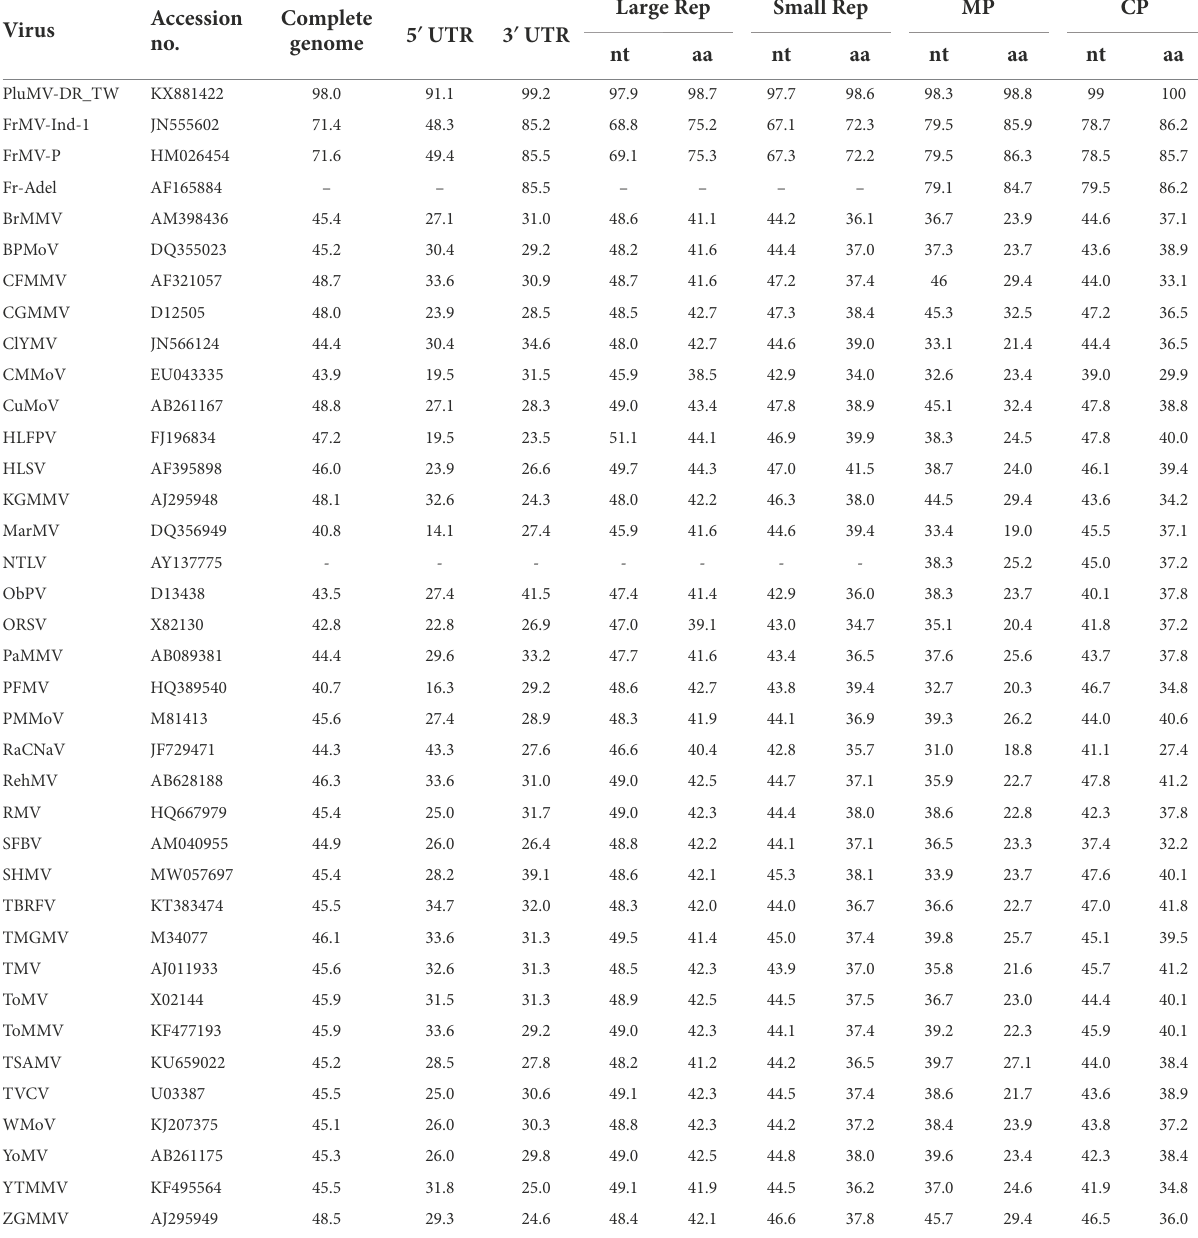
TABLE 3 Percent nucleotide/amino acid sequence identity of plumeria mosaic virus isolate, PluMV-Plu-Ind-1 from India with the isolate from Taiwan (PluMV-DR_TW), and with the other tobamoviruses. Accession Virus